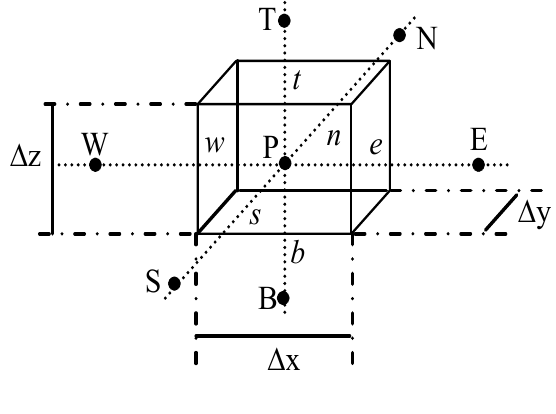
Figure 1: Elementary finished